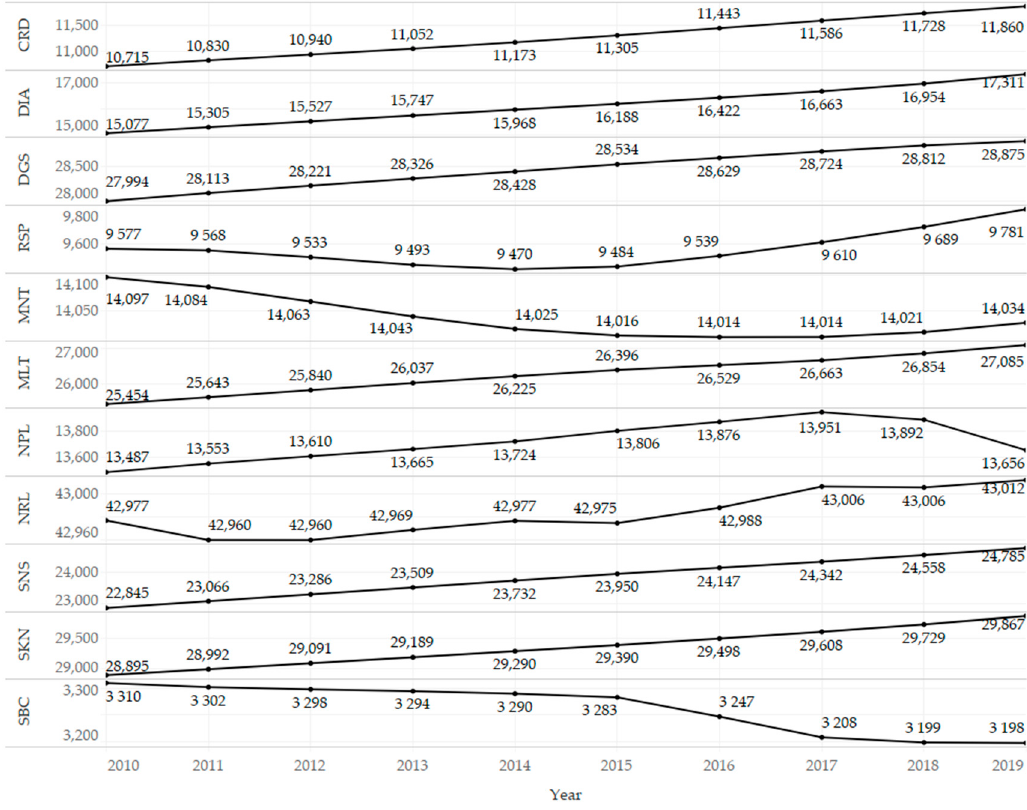
Figure 2. Development of the prevalence of diseases classified into selected diagnosis groups (per population of 100,000) in the observed period (2010–2019).